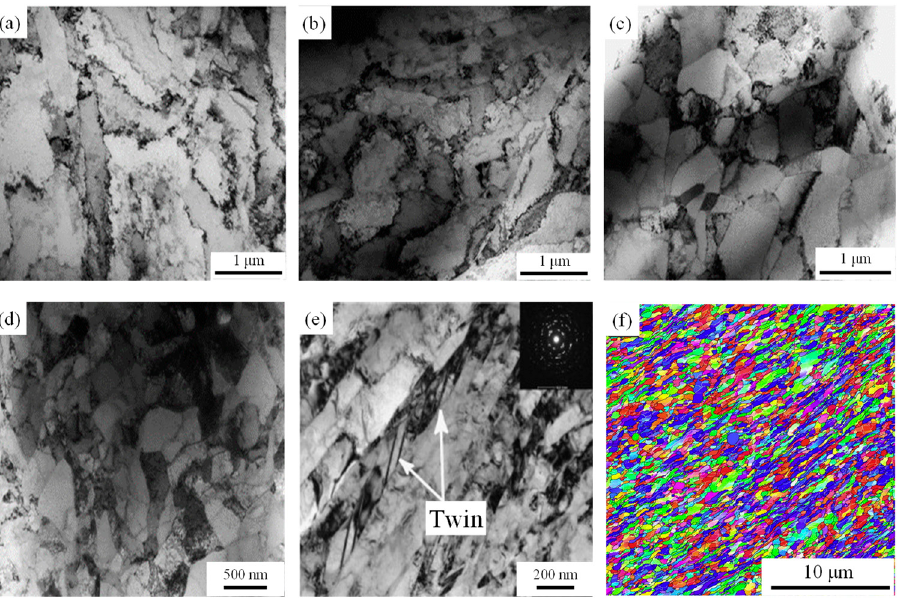
Figure 10. TEM and EBSD images of the microstructure of Copper Alloys after ECAP for ( a ) one pass; ( b ) two passes; ( c ) four passes; ( d ) eight passes [69]. Reproduced with permission from Elsevier B.V. ( e ) twelve passes [70]. Reproduced with permission from Elsevier B.V. ( f ) sixteen passes [18]. Reproduced with permission from Elsevier Inc.